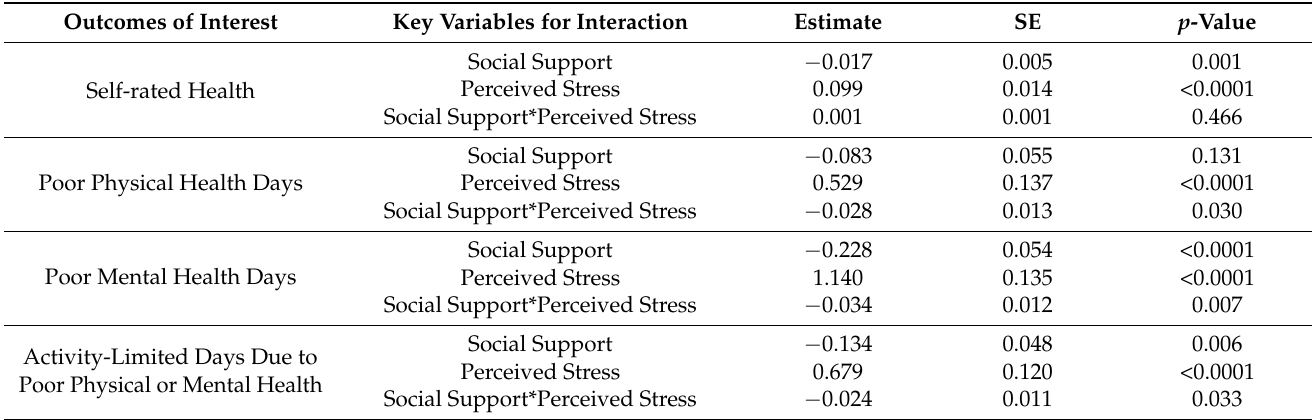
Table 3. Linear regression model predicting health-related quality of life among individuals experiencing homelessness in Oklahoma City, OK ( N =